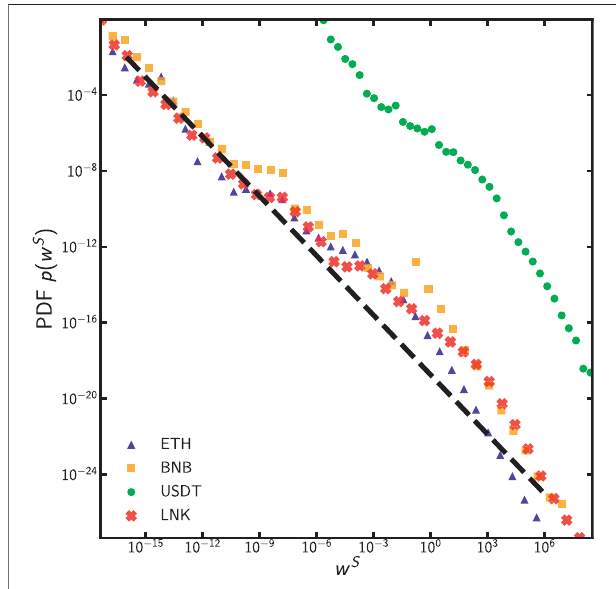
FIGURE 1 | PDF of wealth w S for w S > 0 in various tokens: ETH, BNB, USDT, and LNK. The dashed line ( w − 1 ) is just added for visual